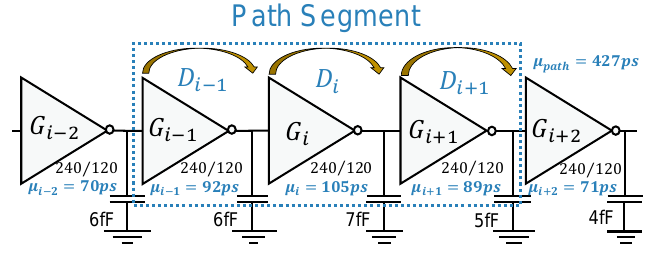
Figure 2. Logic path composed of